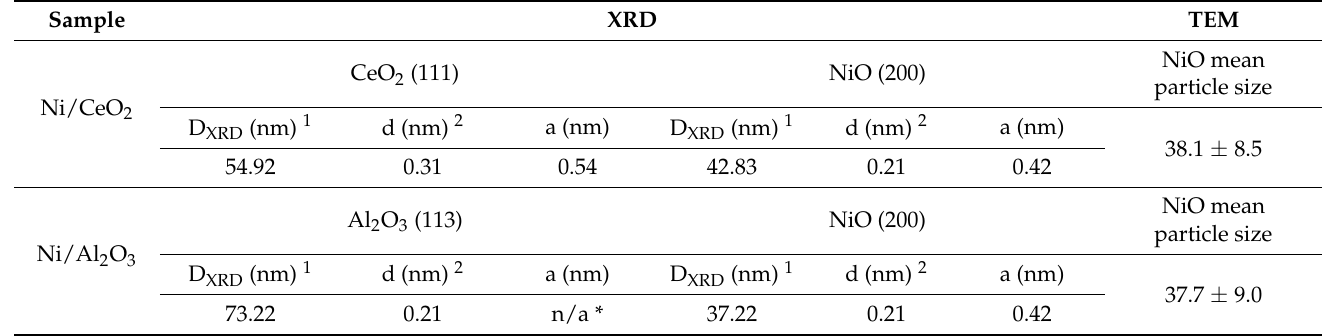
Figure 1. XRD patterns of Ni-based and MS-Ni-based catalysts. Table 1. XRD and TEM results for the as-prepared Ni/CeO 2 and Ni/Al 2 O 3 catalysts.